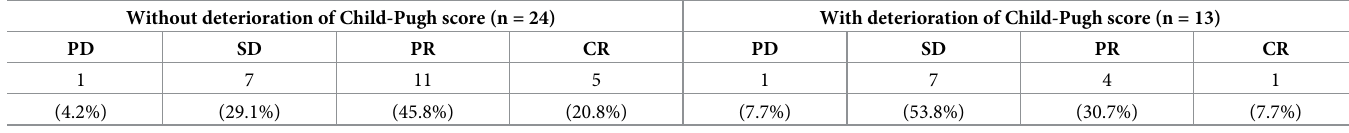
Table 2. Treatment response comparison between patients with or without deterioration of Child-Pugh scores during treatment with lenvatinib for HCC. Without deterioration of Child-Pugh score (n = 24)